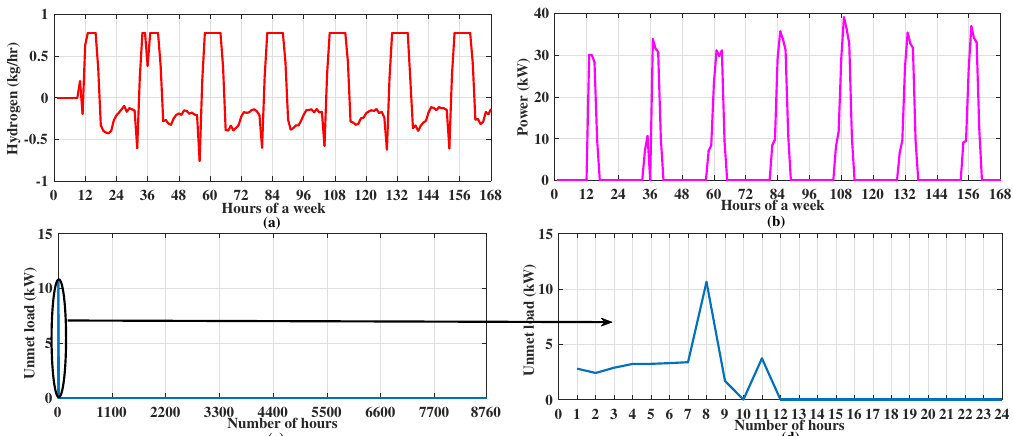
Figure 6. ( a ) Hydrogen consumption and production in one week; ( b ) excess electricity produced by the system for a week; ( c ) unmet demand throughout the year; ( d ) unmet demand on the very first day of simulation.